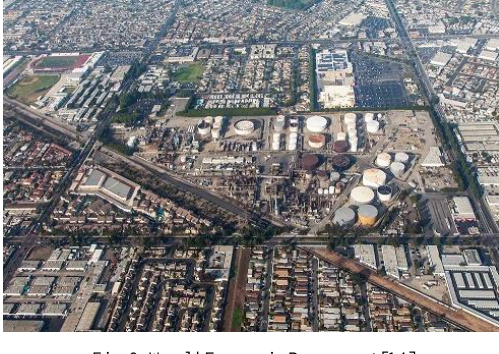
Fig. 9. World Energy in Paramount [14]